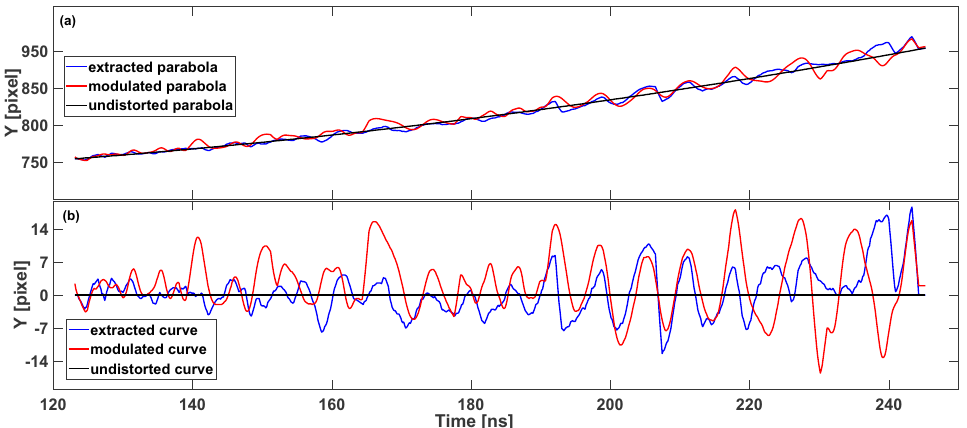
Figure 6. ( a ) Extracted (blue), modulated (red), and undistorted (black) parabolic track corresponding to protons. ( b ) Obtained curves from parabolas by subtracting parabolic dependence (1). X axis was the same in both figures. The direction of the y axis in ( a ) is the opposite with respect to Figure 2. Y axis in ( b ) shows the modulation amplitude in